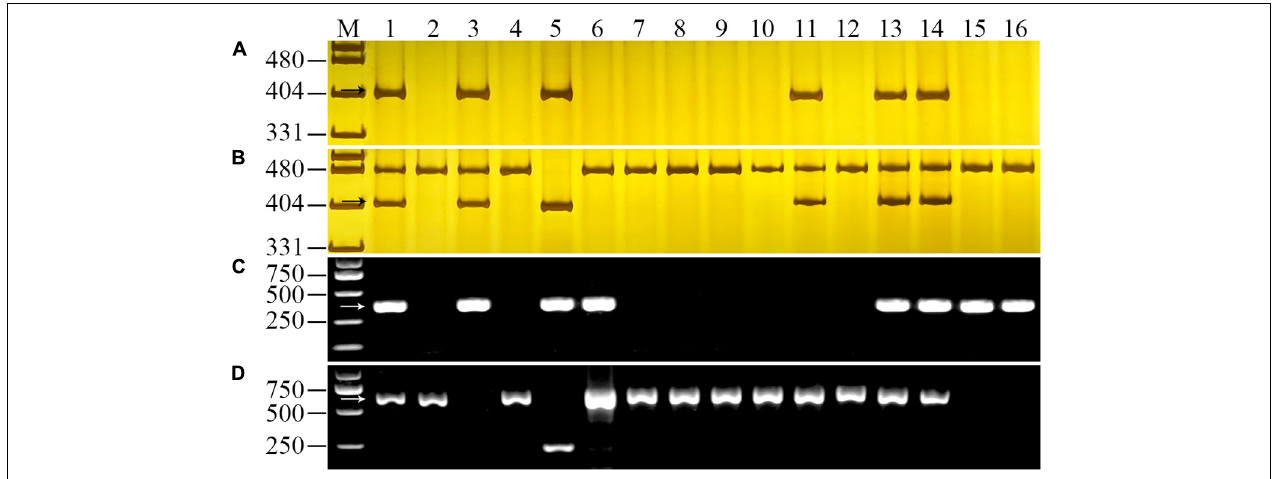
FIGURE 2 | PCR amplification of 6RS-specific marker SW22057 (A) , 6RL-specific marker SW22063 (B) , 1RS-specific marker SW5284 (C) , and 1BS-diagnosed marker O11B3/O11B5 (D) for chromosome composition analysis of YT2. Lanes M, pUC19 Msp I in (A,B) and Trans2K Plus in (C,D) . 1, octoploid triticale 09R2-100; 2, Shixin 616; 3, YT2; 4, Chinese Spring; 5, Imperial rye; 6–12, 1R-7R disomic addition lines of “Chinese Spring × Imperial”; 13–14, two hexaploid triticale lines 10R2-193-2 and 10R2-194-2; 15–16, two T1BL · 1RS translocation lines Lovrin 10 and Lovrin 13. The arrows indicated the diagnostic fragments of the